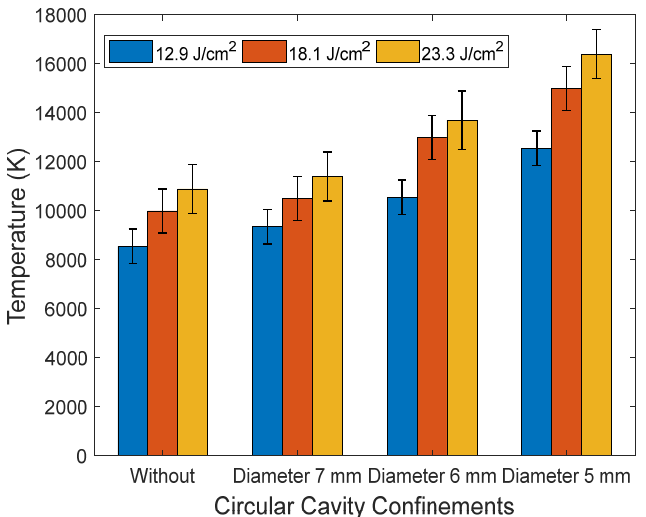
Figure 13. A graph of electron temperature versus the circular cavities with different sizes and without cavity confinement, at laser fluences 12.9, 18.1 and 23.3 J cm − 2 .